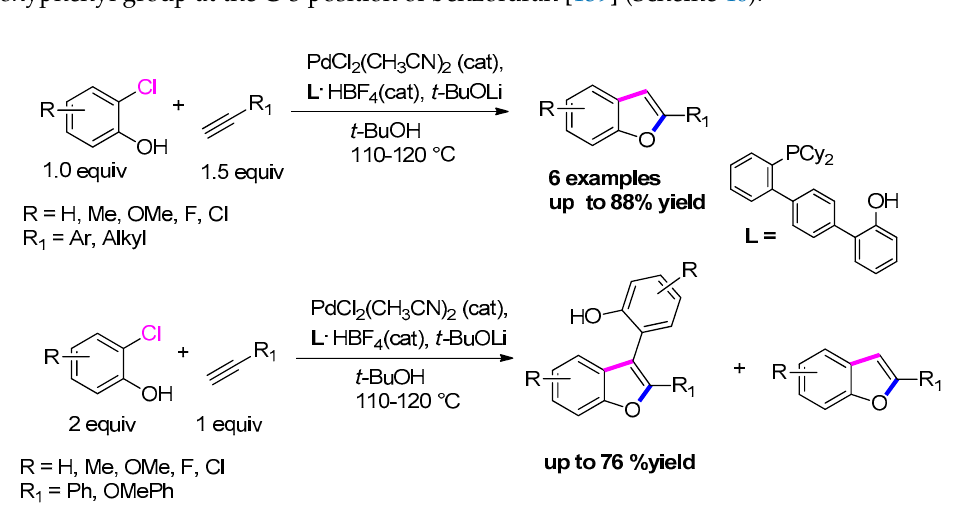
Scheme 46. Synthesis of benzofurans via o-halophenol and terminal alkynes.